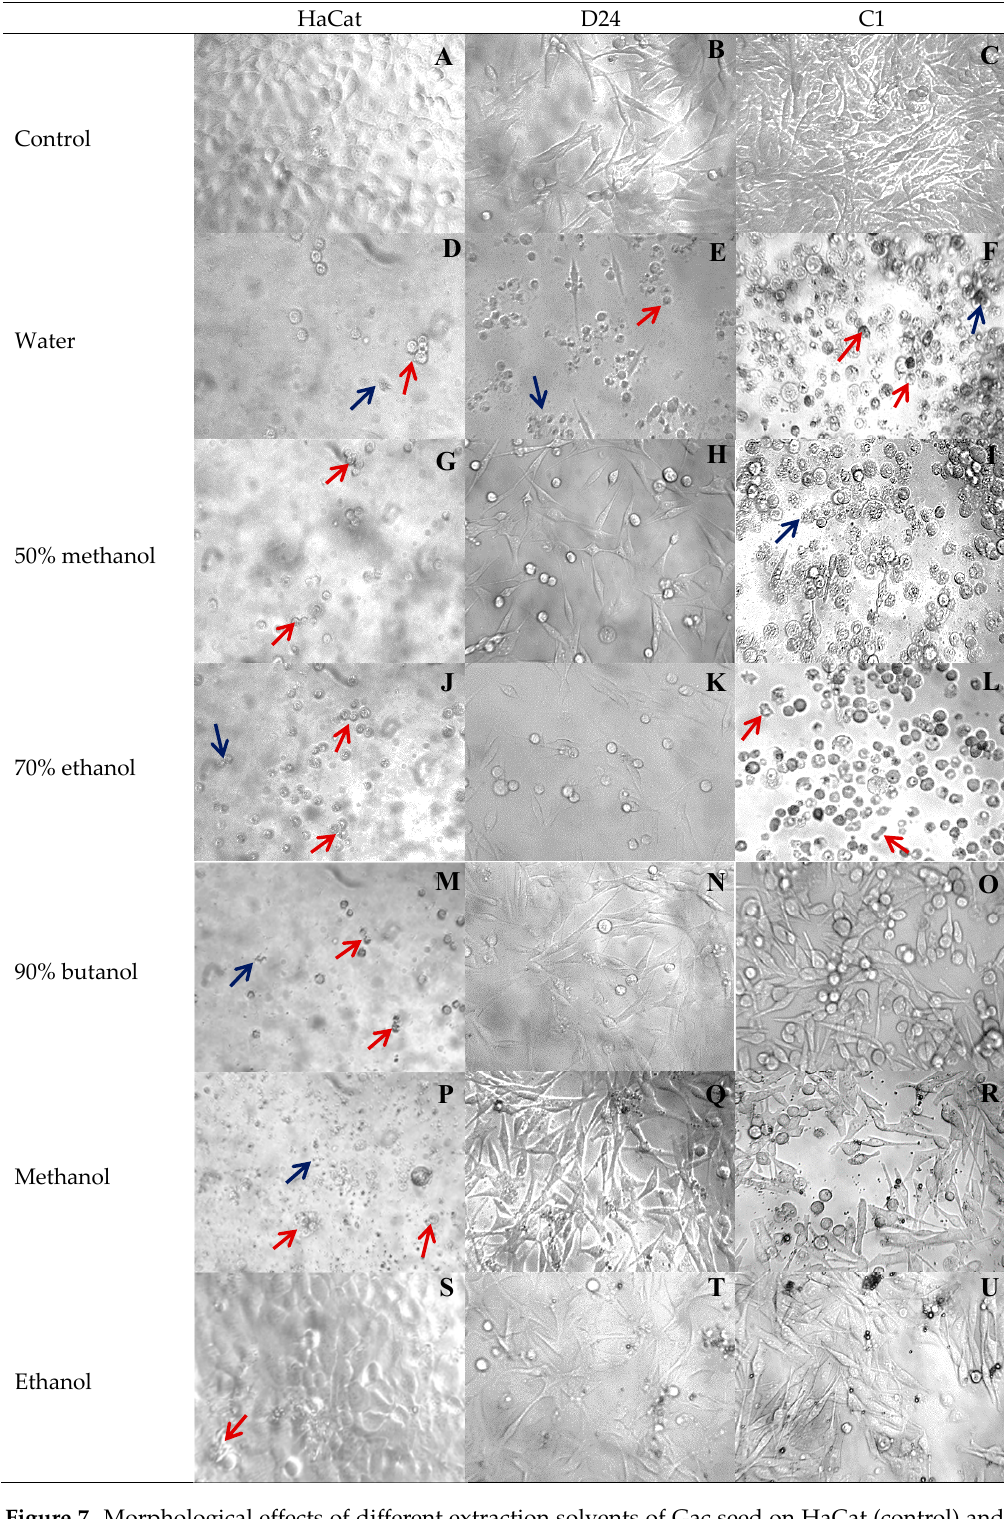
Figure 7. Morphological effects of different extraction solvents of Gac seed on HaCat (control) and melanoma D24 and C1 cell lines observed under a phase contrast microscope after 48 h treatment. Cytotoxicity is indicated by red arrows pointed to condensation and detached cells; blue arrows pointed to apoptotic bodies. Magnification: 100 ×